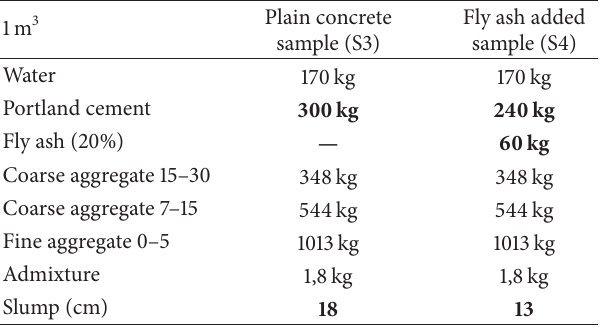
Table 5: Mix ratio of 1m 3 concrete and slump